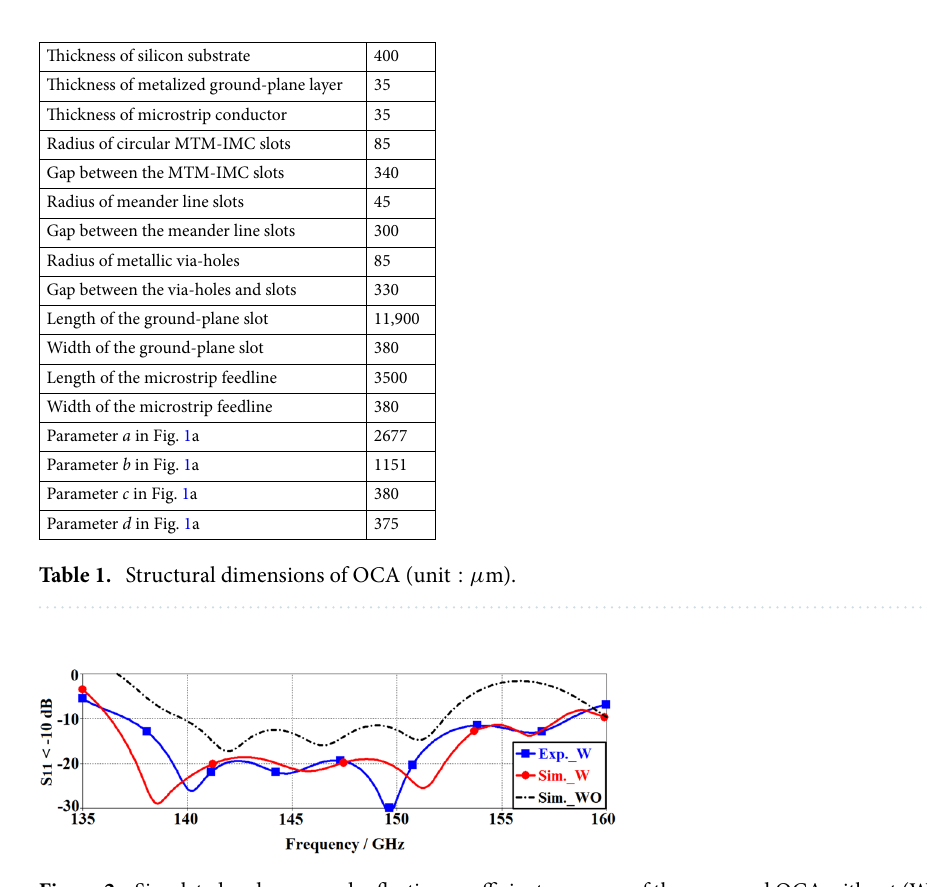
Figure 2. Simulated and measured reflection-coefficient response of the proposed OCA without (WO) and with (W) the MTM-IMC termination and